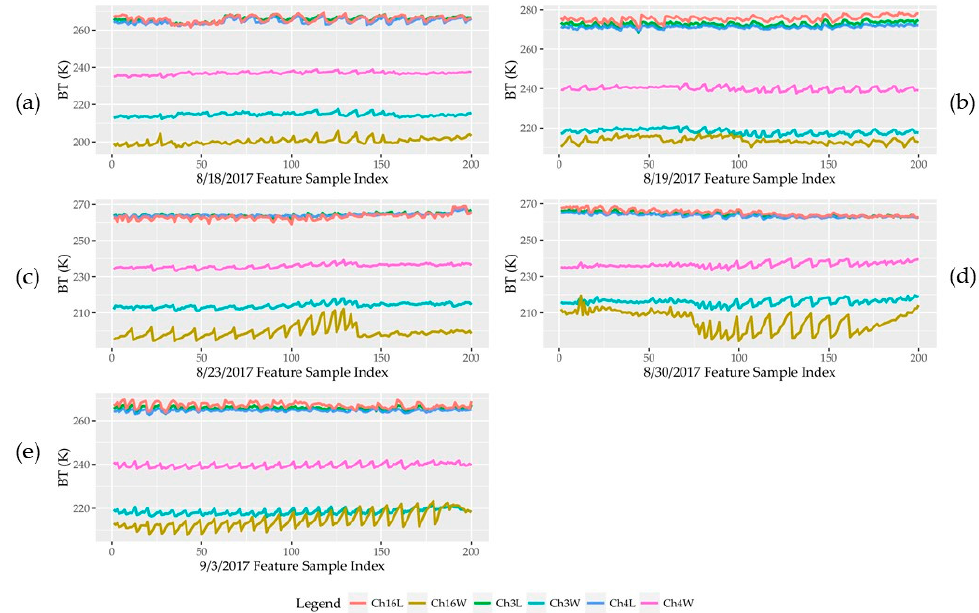
Figure 3. ( a – e ) shows temperature (BT) values of channel 3–4 and 16 of land samples and water samples collected from 18–19, 23, & 30 August 2017 and 3 September 2017 ATMS data. Ch3W (Ch3L), Ch4W